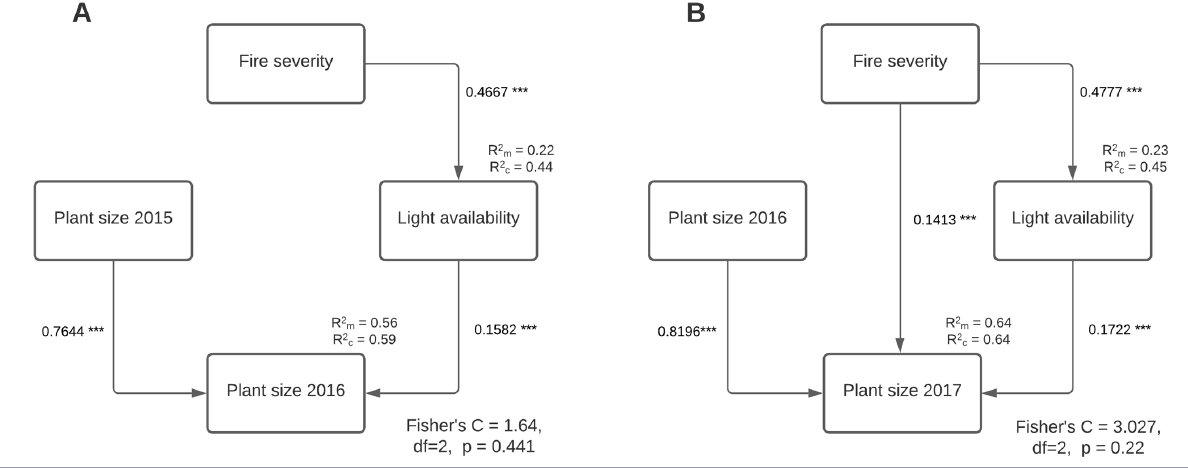
Fig. 2. In the best-supported model for plant growth one to two years post-fire, light availability mediated the impact of fire severity on plant growth, whereas direct effects of fire on plant growth were not significant (p = 0.44; n = 858) (A). From two to three years post-fire, in the best-supported model, the direct effects of fire on growth were somewhat larger (0.14) than the indirect impacts mediated by light availability (total indirect: 0.4777*0.1722 = 0.0823; n = 852) (B). Shown are standardized path coefficients. *** indicates p < 0.001. Site was included as a random effect in both models. Site explained about half of the variation in light availability and very little to none of the variation in growth. Fisher’s C > 0.05 indicates a good model